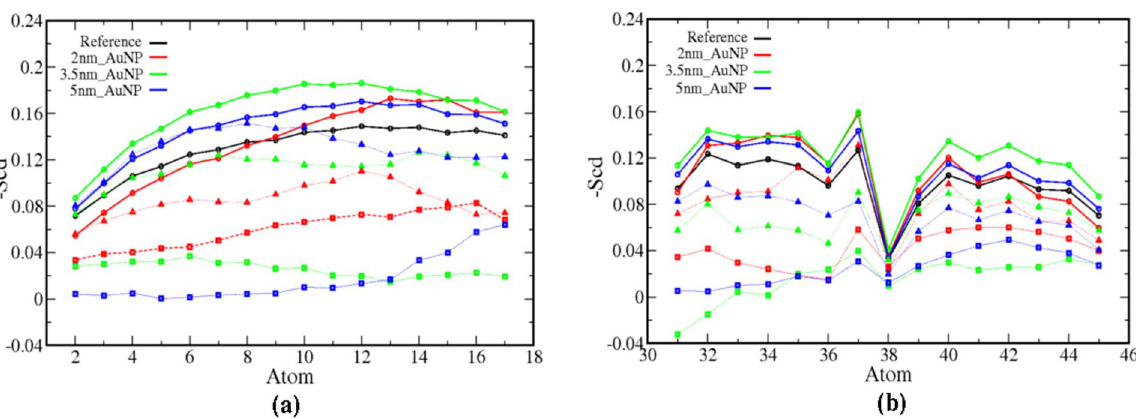
Figure 6. -S cd order parameters of chains (a) sn1 and (b) sn2 . Symbols square, triangle and circle represents short range, buffer region and long range